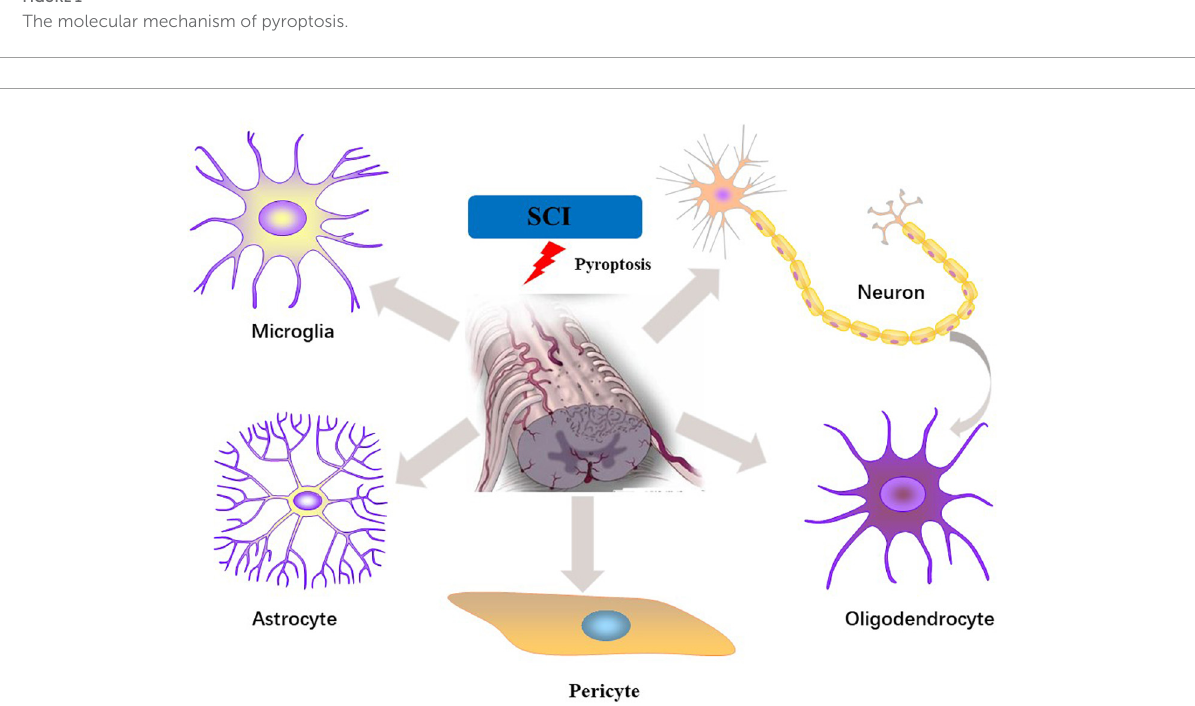
FIGURE2 Pyroptosis in different cell types of the spinal cord following SCI.